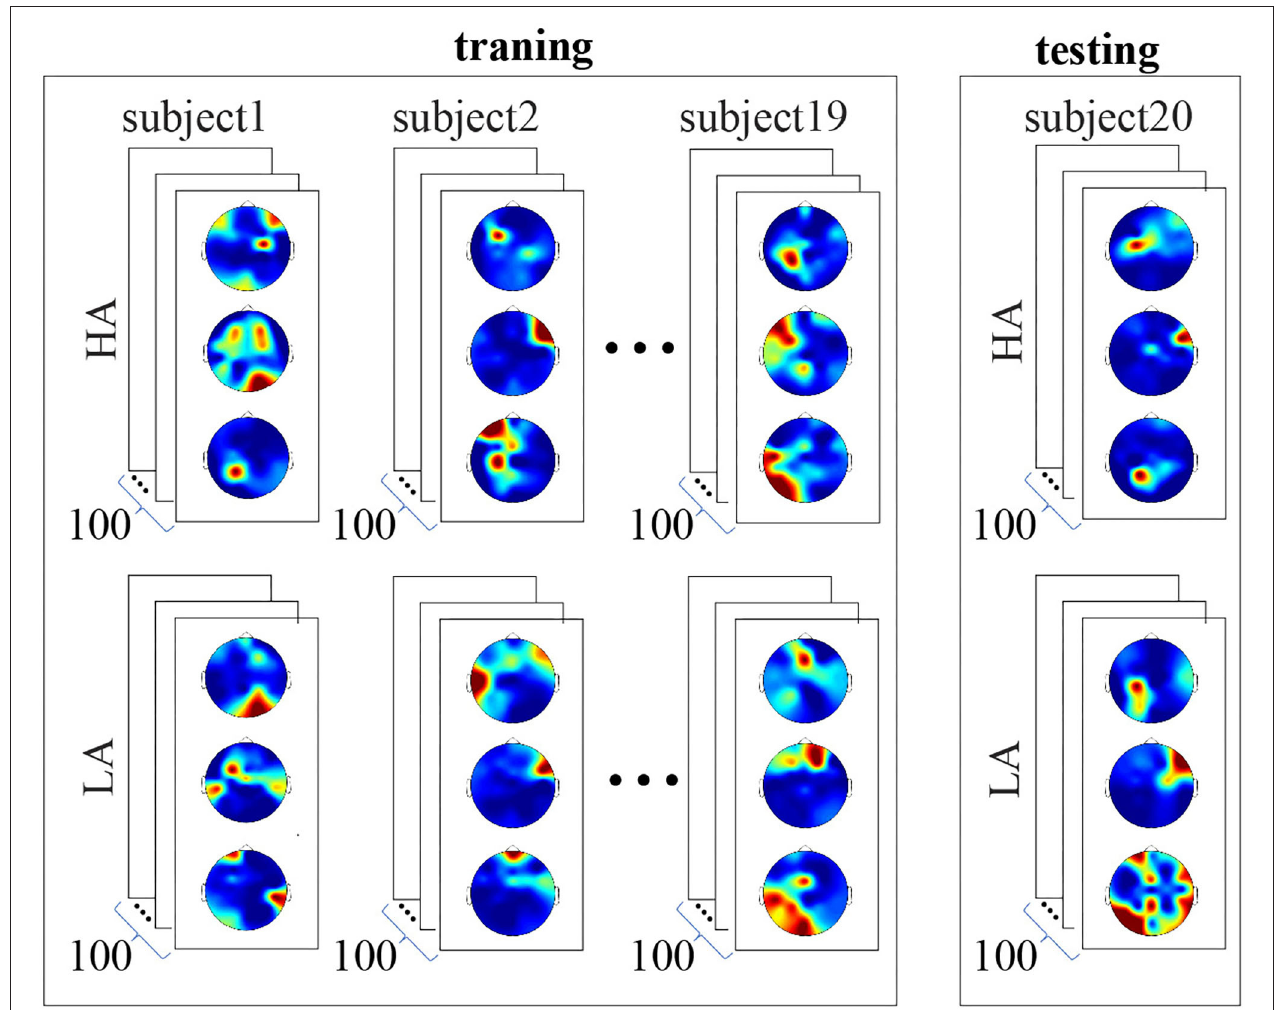
FIGURE 3 | Structure of the training and testing datasets. The training set includes data of 19 subjects, 11,400 images in total. Each subject’s data includes 600 images, 300 LA, and 300 HA topograms. The testing set includes data of the remaining single subject. It consists of 600 images, 300 LA, and 300 HA topograms. Convolutional neural network (CNN) did not learn the data of the test